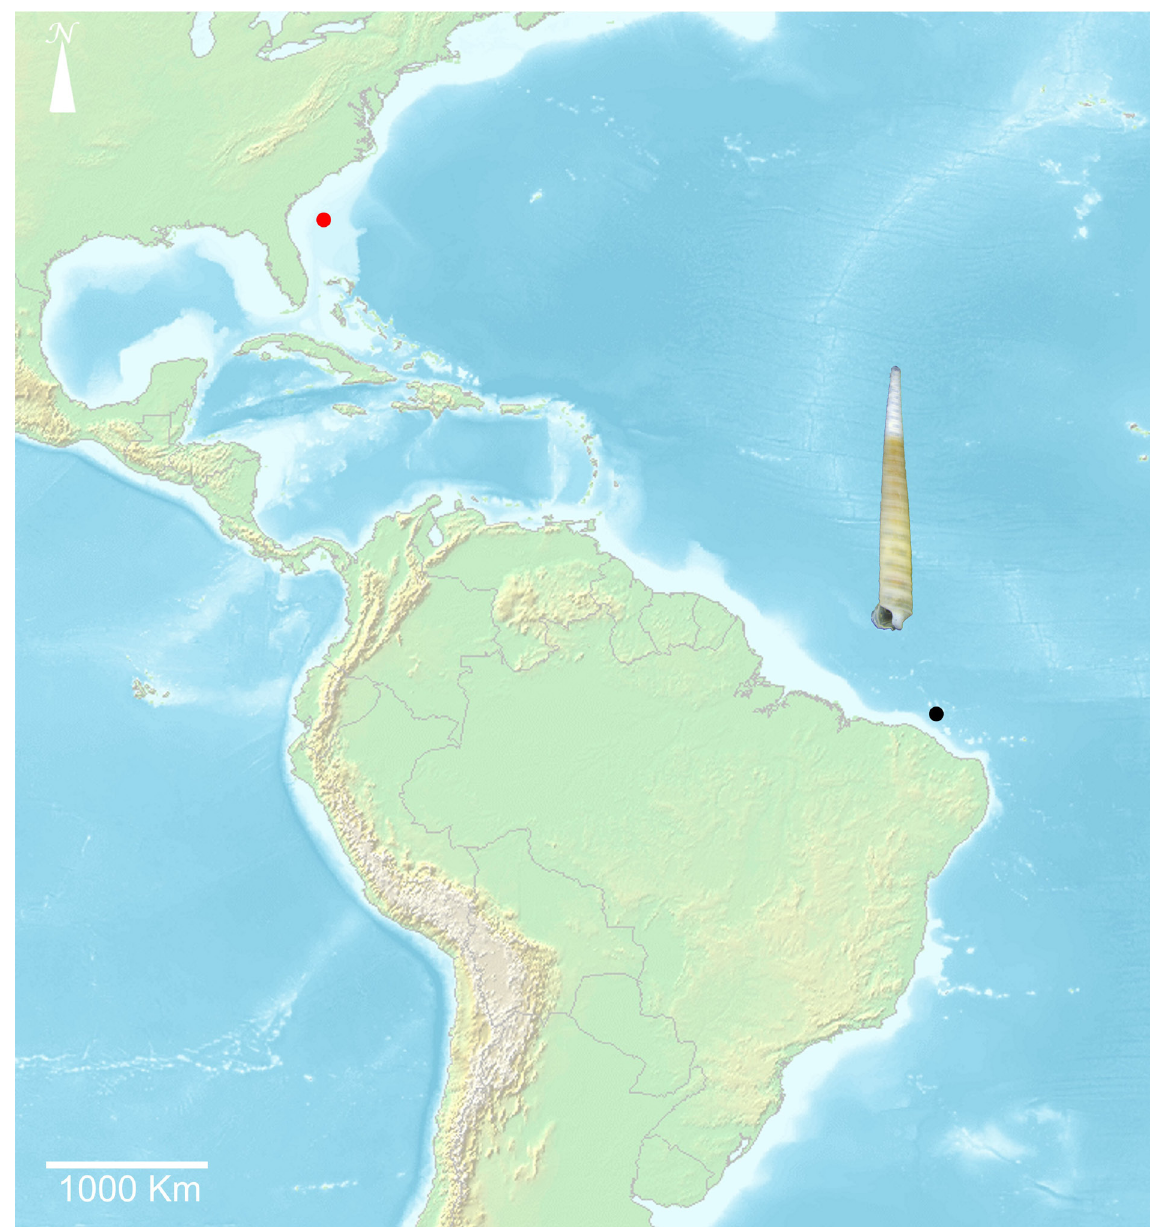
Fig. 70. Distribution map of Strobiligera gaesona (Dall, 1927); red circle = type